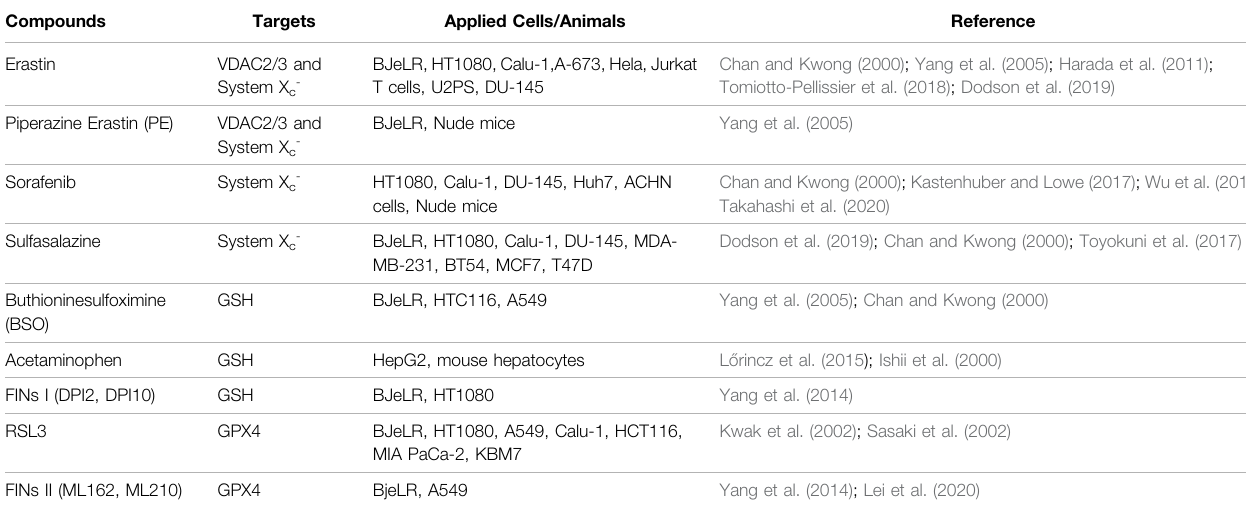
TABLE 1 | Summary of the available ferroptosis